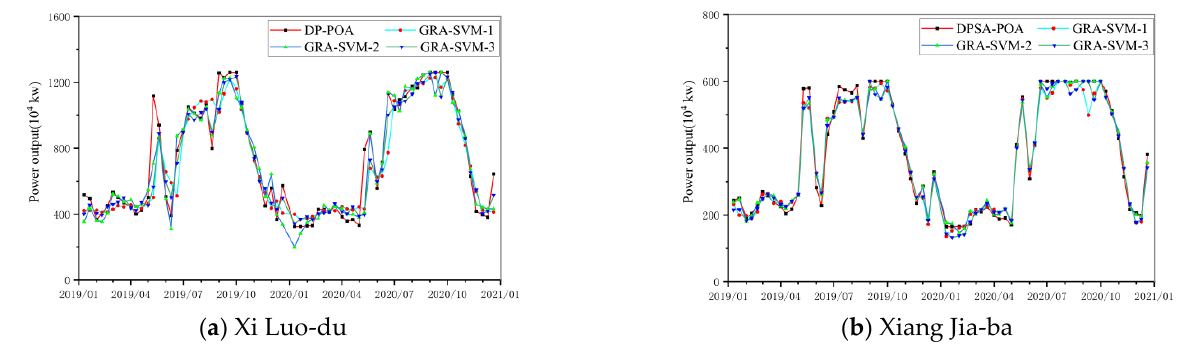
Figure 4. PAPS of obtained time series of power output.